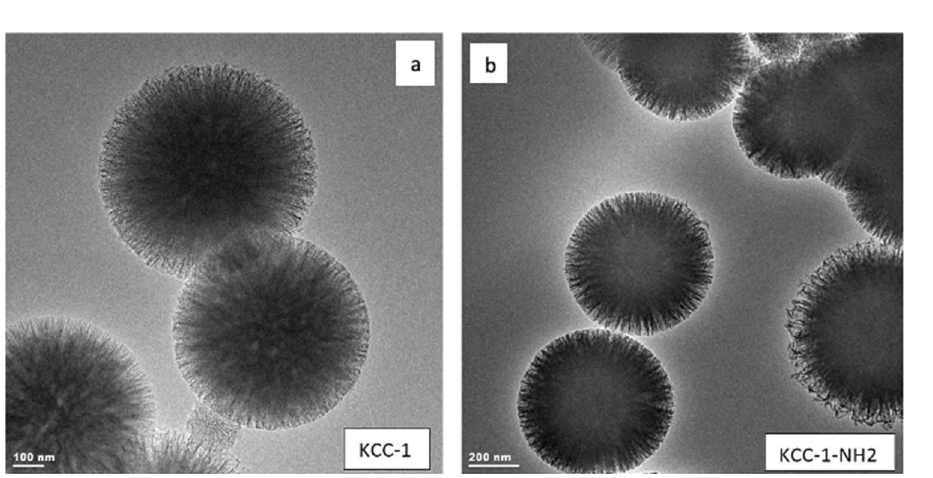
Figure 1. FESEM images of ( a ) KCC-1 and ( b ) KCC-1-NH 2 . The middle diagram is particle size distribution for KCC-1.